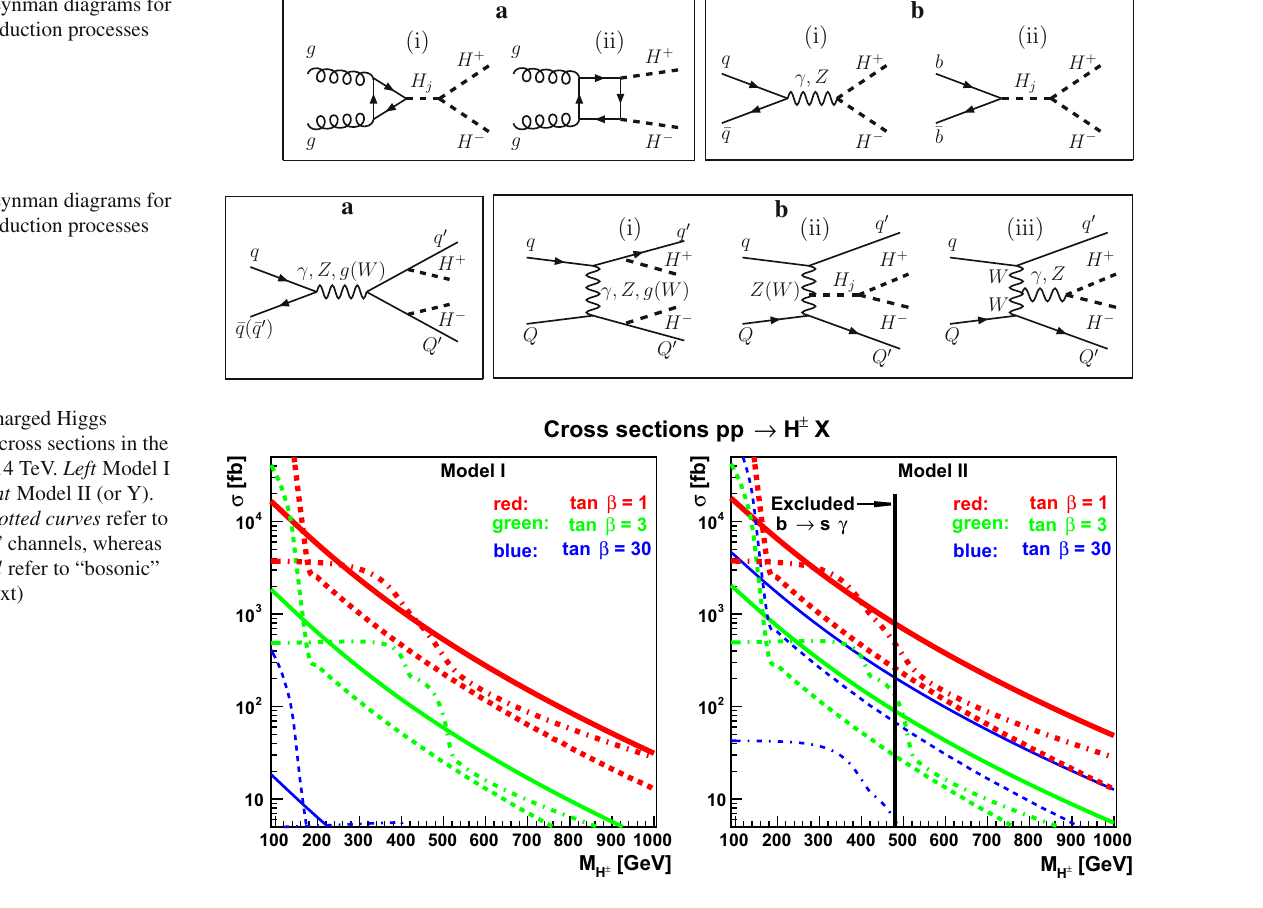
Fig. 14 Feynman diagrams for the pair production processes (6.10b)